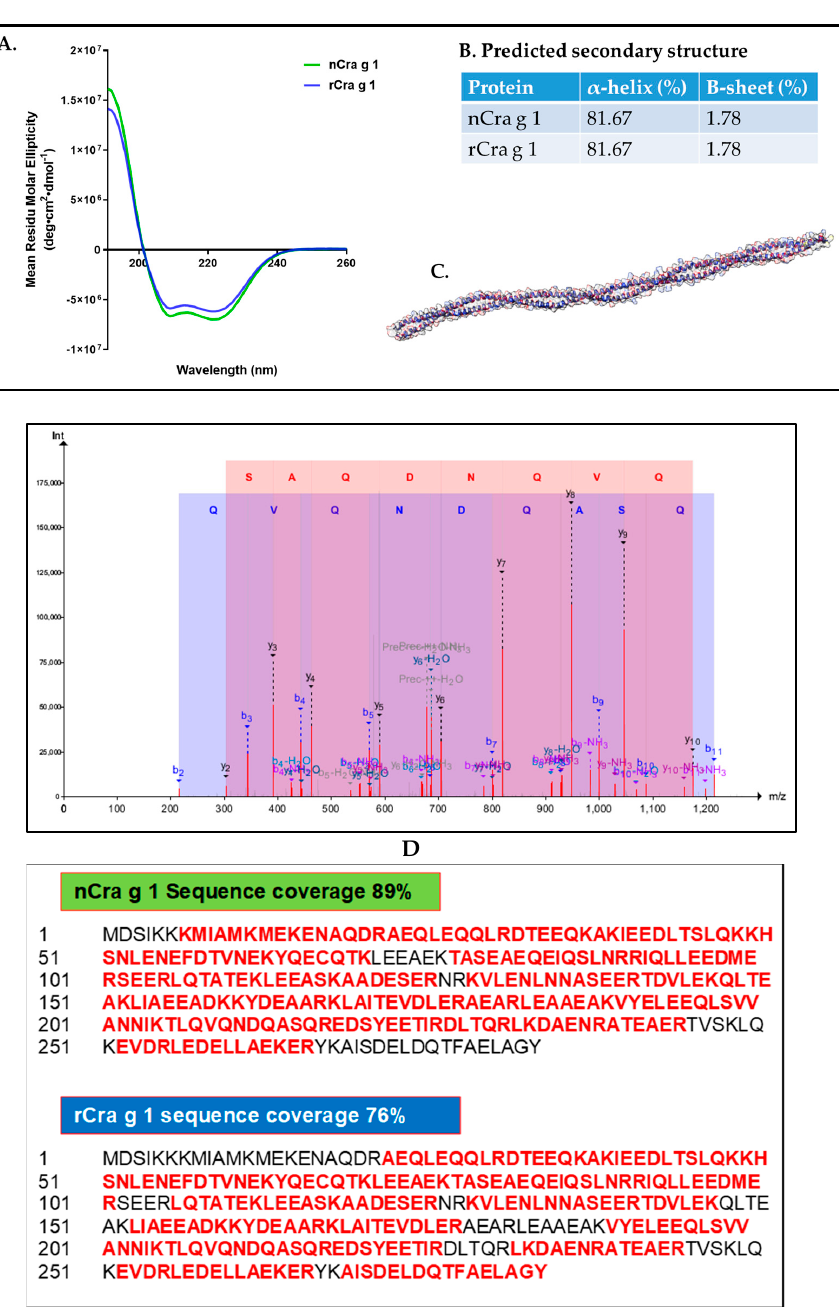
Figure 4. Structural analysis of the purified natural and recombinant tropomyosin. ( A ) Circular dichroism (CD) spectroscopy profile of natural (green line) and recombinant tropomyosin (blue line). ( B ) The estimated structure of tropomyosin predicted using K2D3 web server [22], with the majority of the structure consisting of an alpha-helix ( C ). ( D ) Representative product spectra of unique peptides of TM generated from trypsin digestion. ( E ) Peptide sequences identified by mass spectrometry are highlighted in red colour, overlaying the genomic deducted full-length sequence (black).